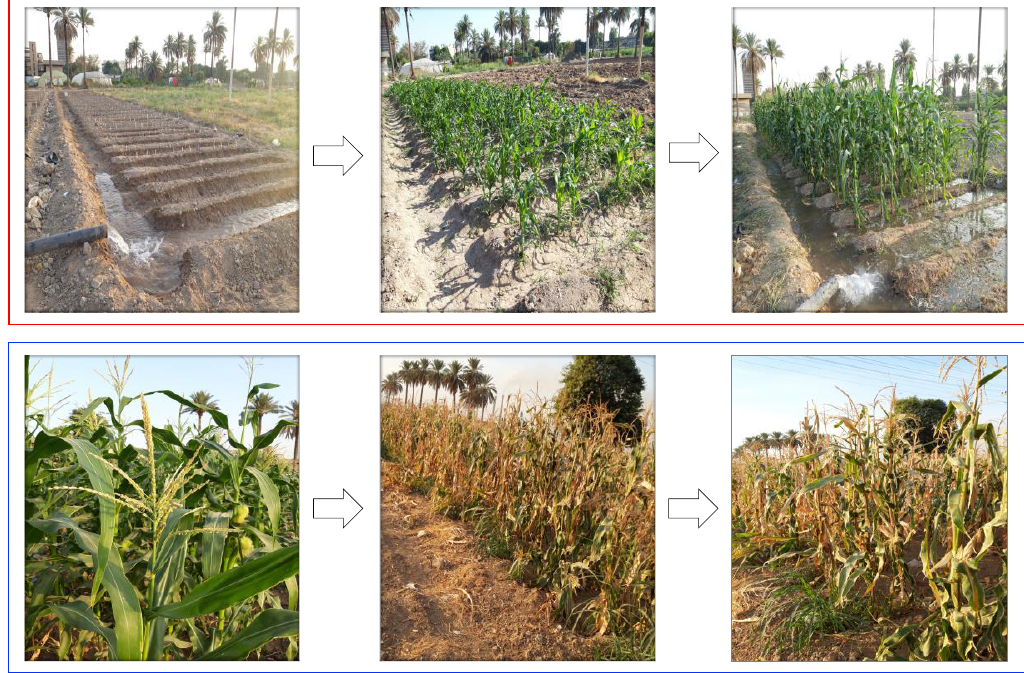
Figure 1. Red box: plant growth stages (sowing at field, emergence stage, and vegetative growth stage). Blue box: plant growth stages (flowering stage, maturity stage, and harvest stage).